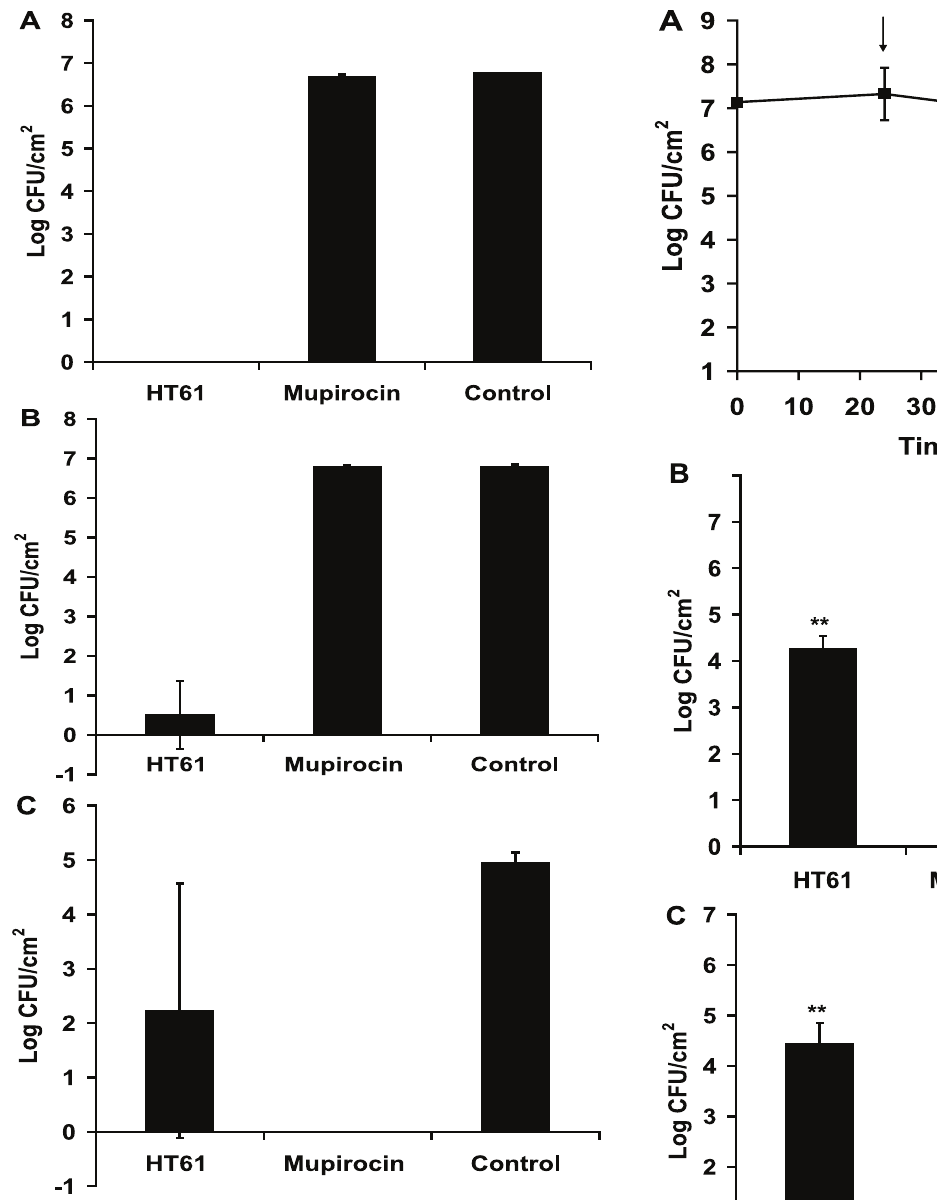
Figure 7. Effect of HT61 against MSSA and MRSA in a murine skin bacterial colonization model. Stationary phase MSSA (A) and MRSA (B) were applied onto 2 cm 2 skin area followed by addition of HT61 gel, Bactroban and placebo (control) for 2 hours. Log phase MSSA were treated with HT61 gel, Bactroban and placebo (control) for 2 hours on mouse skin (C). The data has been repeated twice. Figure 8. Effect of HT61 against MSSA and MRSA in a murine